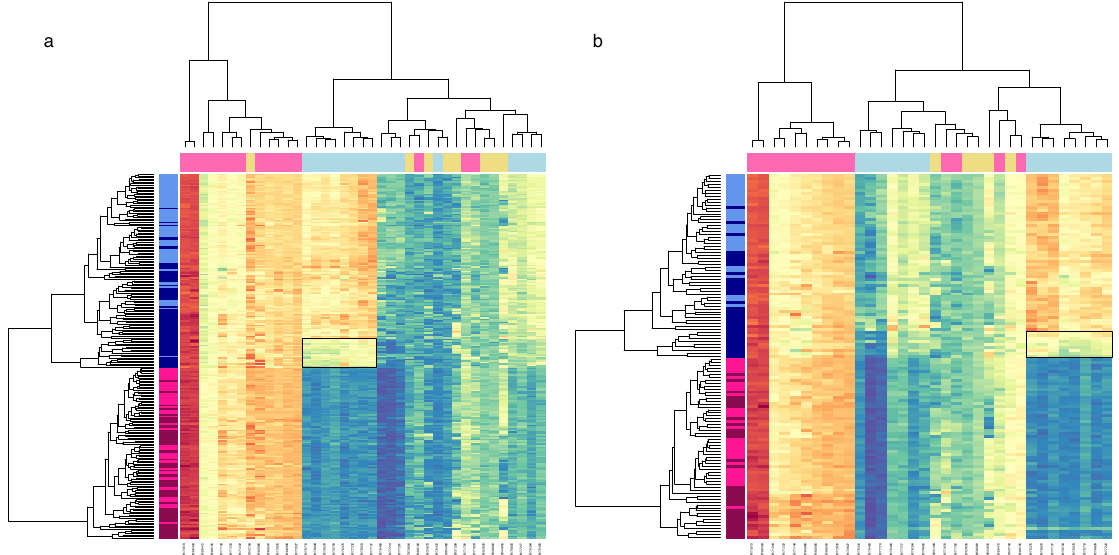
Figure 1. Hierarchical clustering of transcripts assigned to a normal-specific sex associated co-expression network. Figure displays heat maps with hierarchical clustering of samples (on the Y axis) and transcripts (on the X axis) in discovery ( a ) and replication ( b ) datasets, limited to transcripts clusters (TC) assigned to the normal-specific, sex associated, gene co-expression network. Expression is shown on a continuous colour scale from blue (low) to red (high). Sample colour ( y axis) reflects tissue type (light—histologically normal, dark— tumour) and sex (blue—male, pink—female). Transcript colour ( x axis) reflects chromosome class (yellow— autosomal, pink—X, blue—Y). Low Y sample/TCs are highlighted by a solid black box. The data presented in this Figure show broad preservation of a co-expression structure amongst these transcripts in the discovery and replication datasets and confirm the presence of a low Y chromosome expression cluster in a subset of male